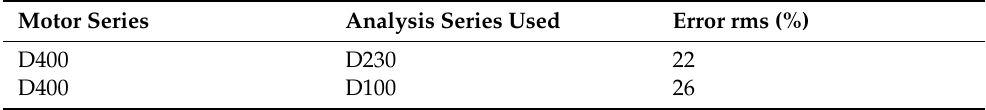
Figure 7. Model scaling performance for D400 based on D230 analysis ( left ) and D100 analysis ( right ). Calculating the regression error RMS for simulated vs. measured regression from Table 3. Scaled model regression error